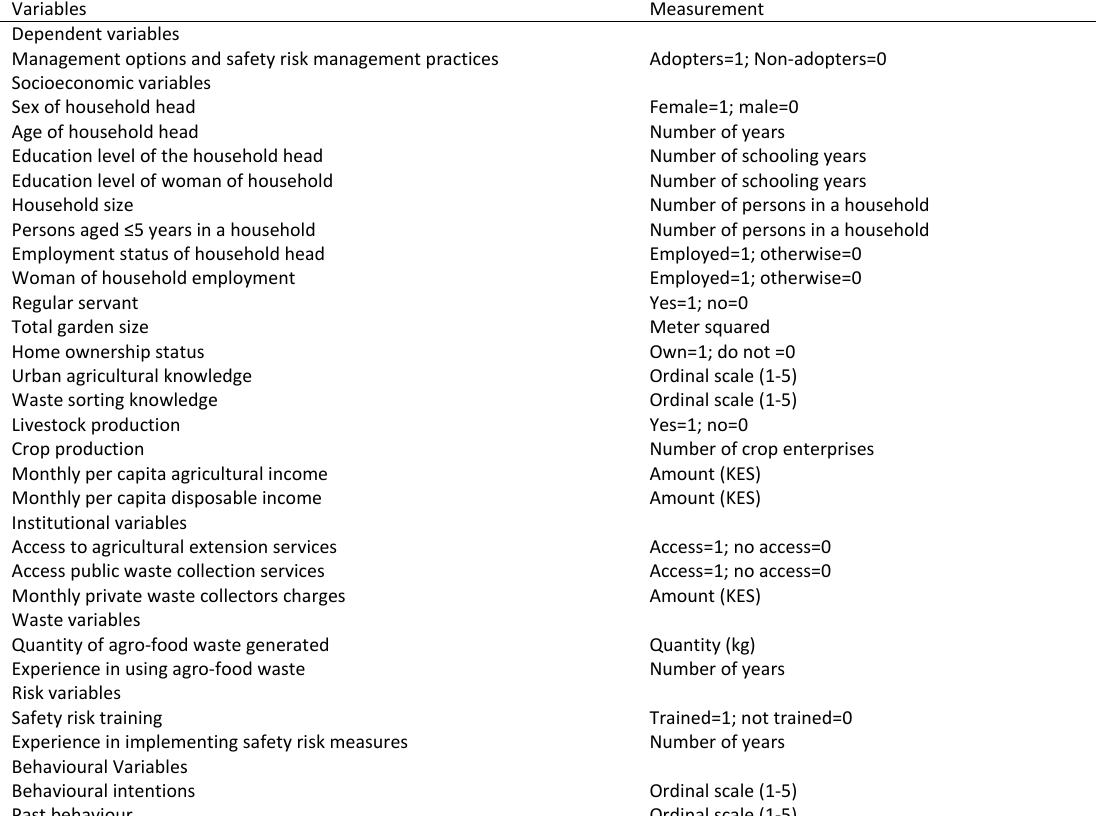
Table 1: Description of variables used for the study